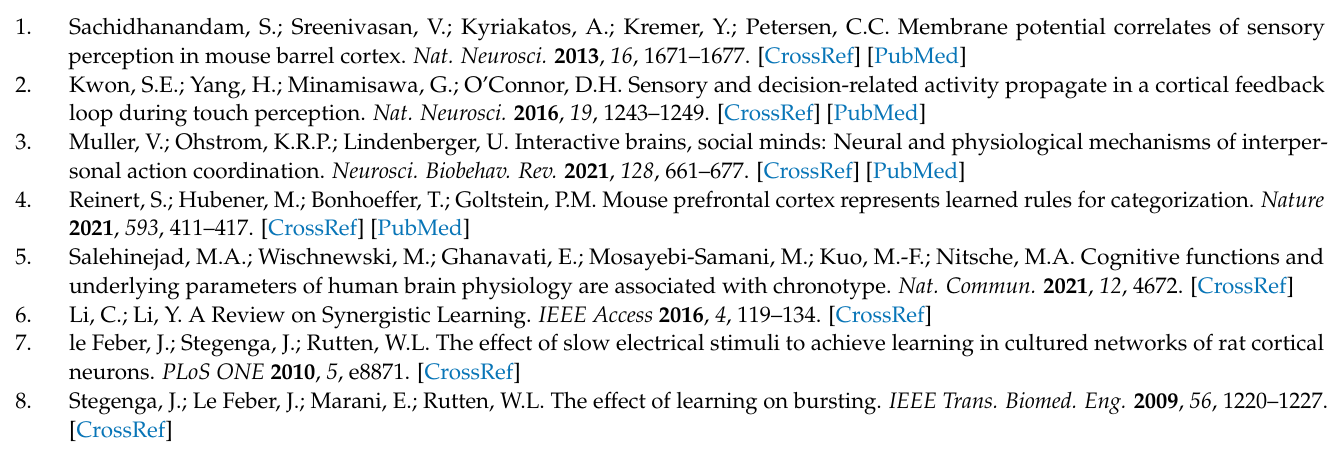
learning; Figure S3: SEM images of the three neural interfaces; Figure S4: Measurements of C dl from cyclic voltammetry experiments; Figure S5: The electrical characteristics of the neural sensor; Figure S6: The biocompatibility and stability of cGO/PEDOT:PSS-modified microelectrodes; Figure S7: The safe potential window of Pt and cGO/PEDOT:PSS; Figure S8: Detecting CIL pulsing currents applied to neural interfaces; Figure S9: SEM images of PEDOT:PSS-modified microelectrodes after multiple CV scans; Figure S10: Neuron classification methods; Table S1: Comparison of electrochemical performance of electrodes modified with different materials. References [44–49] are cited in the Supplementary